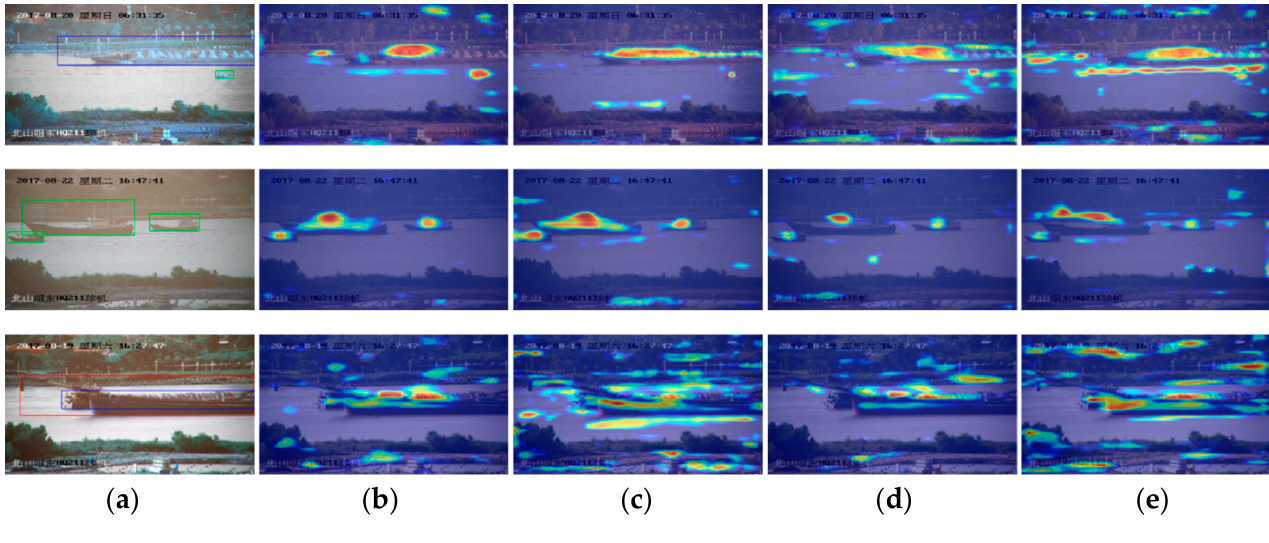
Table 3. Ablation experiment.